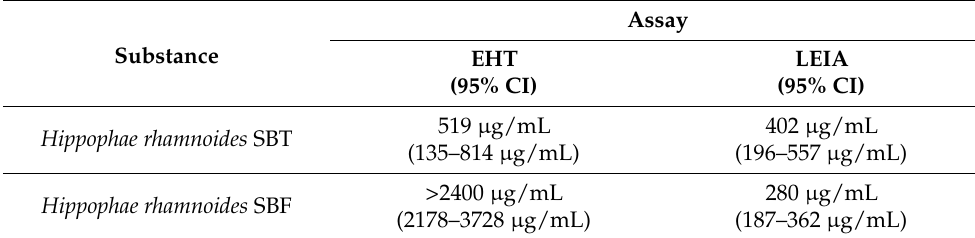
buckthorn from Friuli-Venezia Giulia,